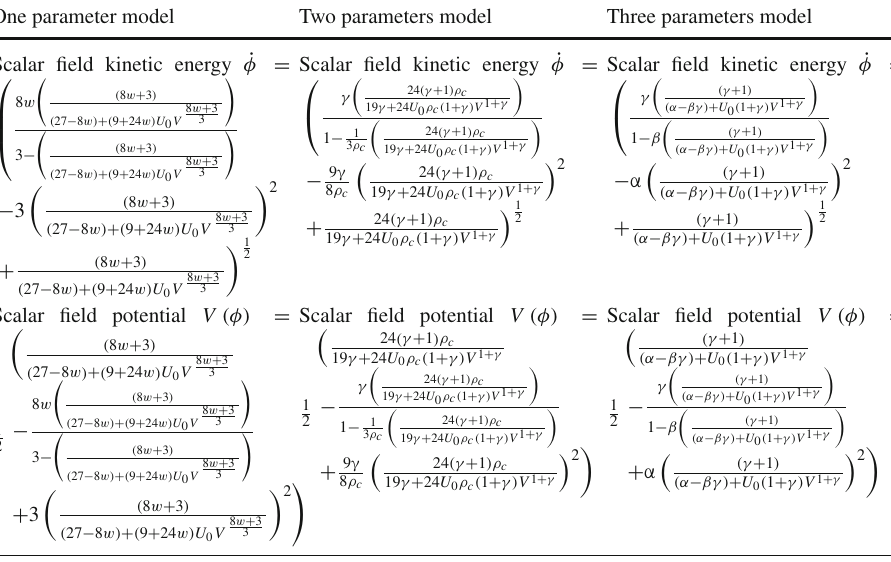
Table 2 Scalar field Kinetic One parameter model Two parameters model Three parameters model energy and Potential energy of the three considered models Scalar field kinetic energy ˙ φ = ⎛ Scalar field kinetic energy ˙ φ =